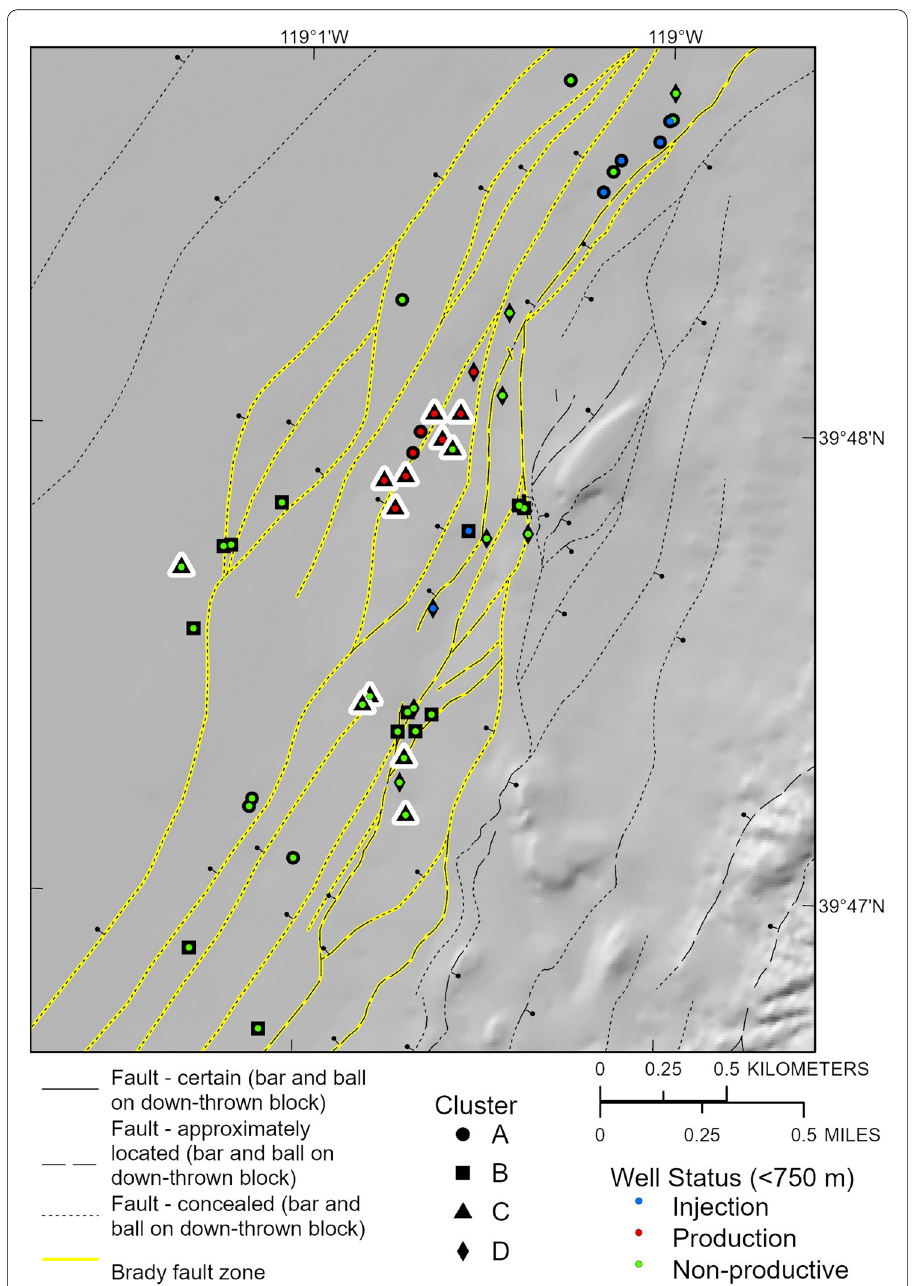
Fig. 5 Map of the Brady well field and fault system. Wells are shown by their use (production, injection, or non-productive) and their cluster ( A , B , C , or D ) as assigned by the NMFk results. Six of the nine production wells are in Cluster C (triangles). Cluster C is highlighted with a white that each well falls into. Figure 6 shows a biplot of S1 vs S2. These two signals most effectively separate the production wells from the injection and non-productive wells. On Fig. 6, the wells and variables are plotted by their S1 and S2 values from Figs. 3A, 4, respectively. The production wells (red) have relatively high S2 values and relatively low S1 values. The variables (plotted as asterisks) that plot in the same quadrant, i.e., also have relatively high S2 values and relatively low S1 values, are those that most